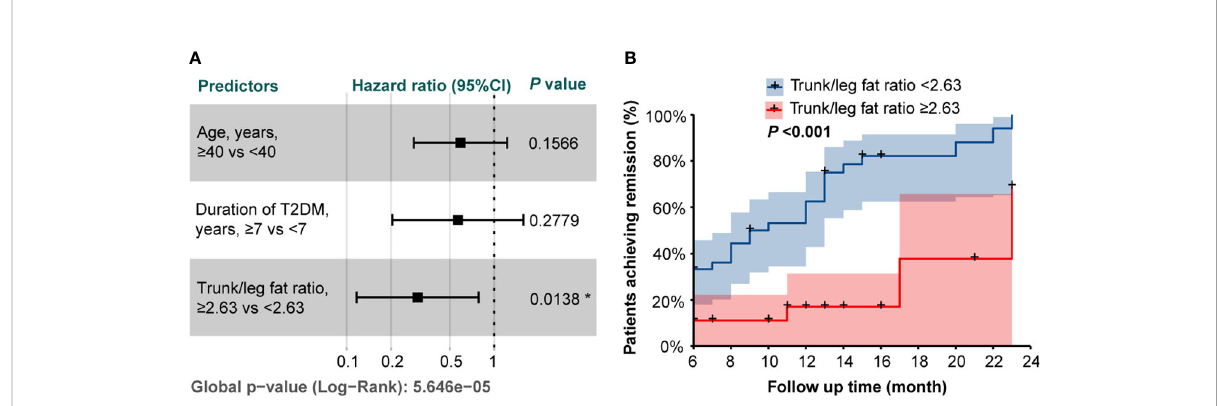
FIGURE 2 (A) The forest plot of the hazard ratios from the Cox proportional hazards model including age, duration of T2DM, and trunk/leg fat ratio. * indicated statistical signi fi cance (P < 0.05). (B) Kaplan-Meier curves strati fi ed by trunk/leg fat ratio with a log-rank